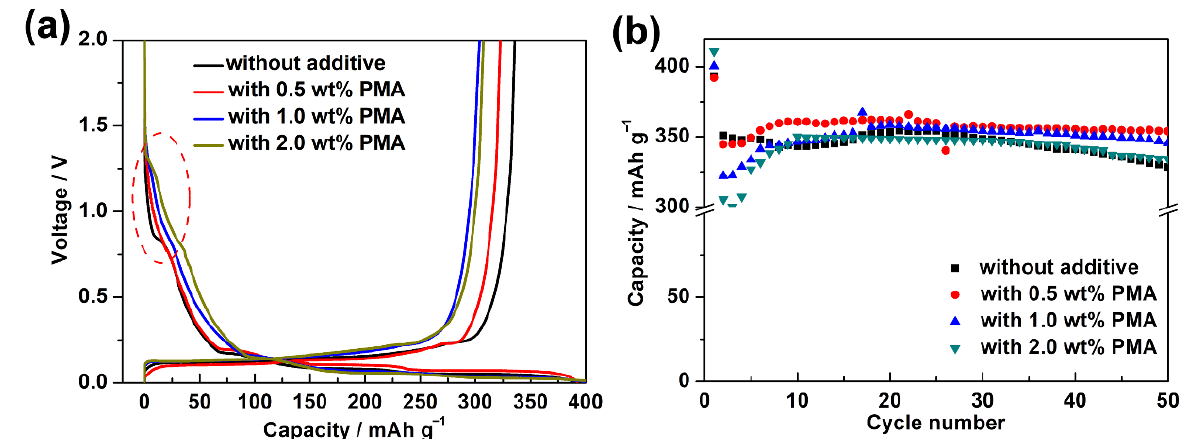
Figure 4. ( a ) Initial galvanostatic charge and discharge curves and ( b ) cycling performance of MCMB electrodes in the base electrolyte containing various PMA concentrations at 0.1C for 50 cycles at elevated